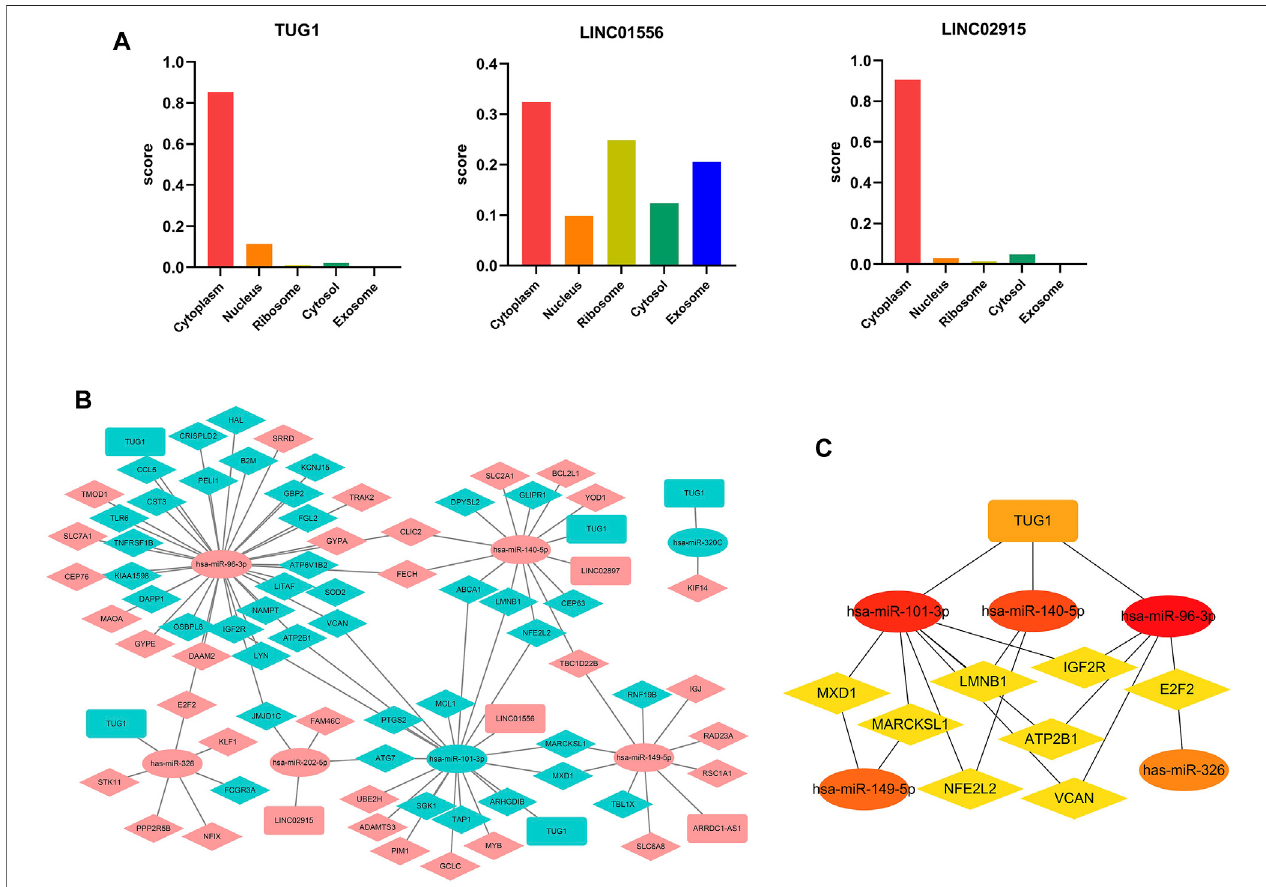
FIGURE6| Construction oftheceRNAnetwork (A) ThesubcellularlocalizationforDElncRNAs predictedbylncLocator. (B) ThetripleceRNAregulatorynetworkin sepsis-induced ARDS. The red dot indicates upregulated genes, and the blue dot represents downregulated genes. The ellipses denote miRNAs, diamonds denote mRNAs, and round rectangles denote lncRNAs. (C) The hub genes in the ceRNA network calculated by MCC algorithm in Cytoscape.